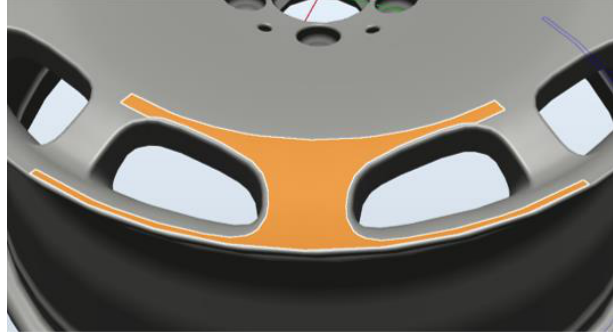
Figure 5. Select the machined surface.